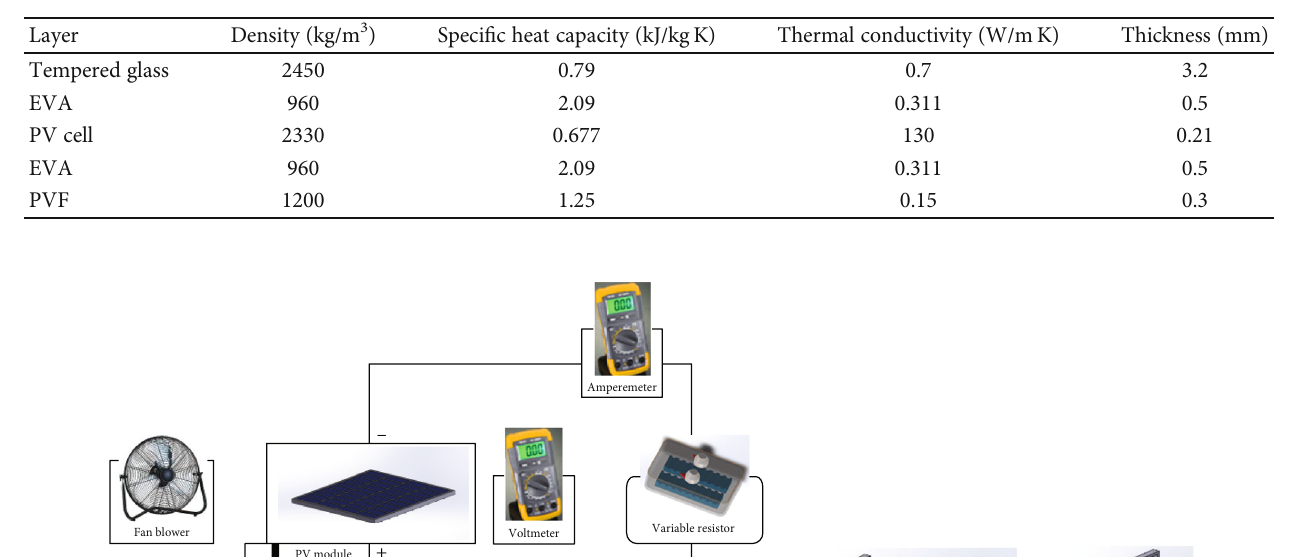
Table 1: The properties of each layer in the solar module.